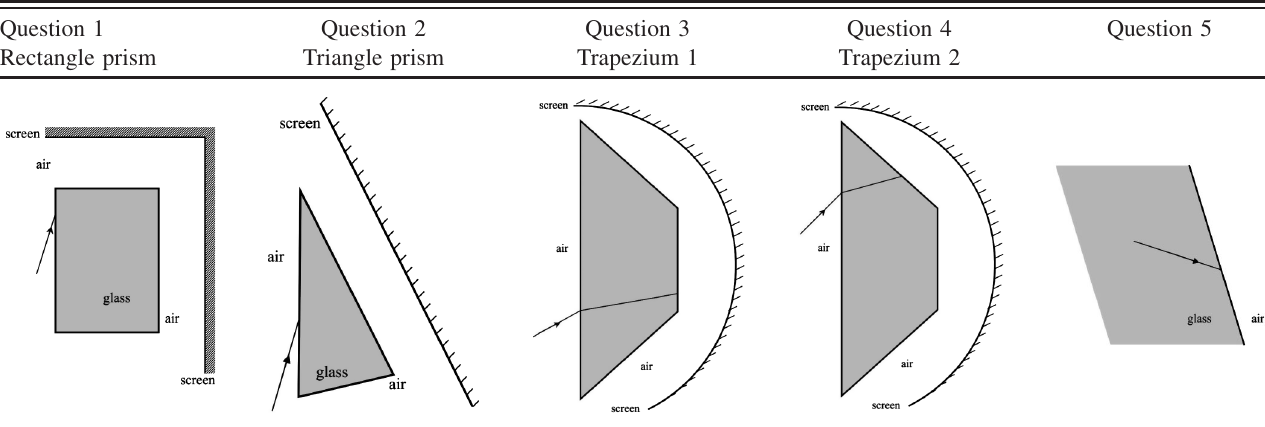
TABLE II. The five assessment questions for experiment 2. The order of presentation of questions 1 and 2, and questions 3 and 4, was counterbalanced. Participants were not allowed to return to a previous question once they had completed it and gone on to the next question.